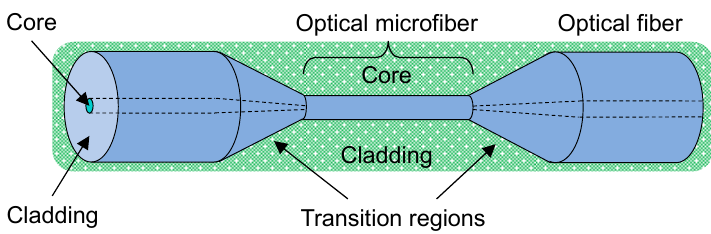
Figure 1. Schematic diagram of an optical microfiber. An example of the new cladding is a liquid analyte (green background).